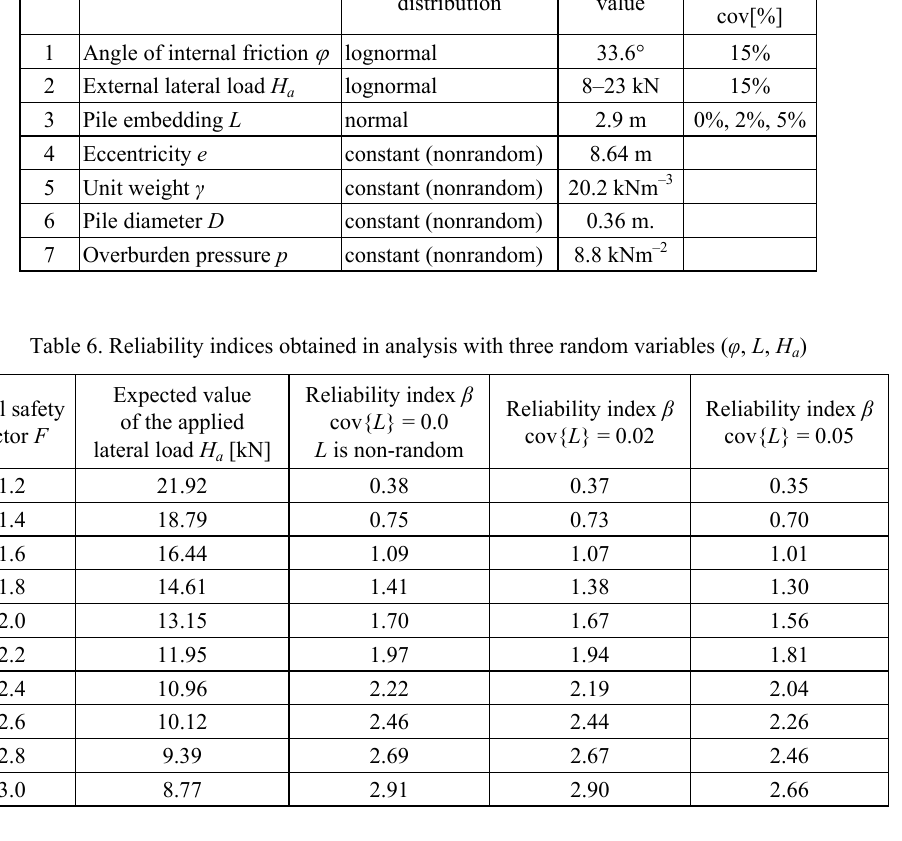
Table 5. Parameter characteristics involved into the problem considered No.